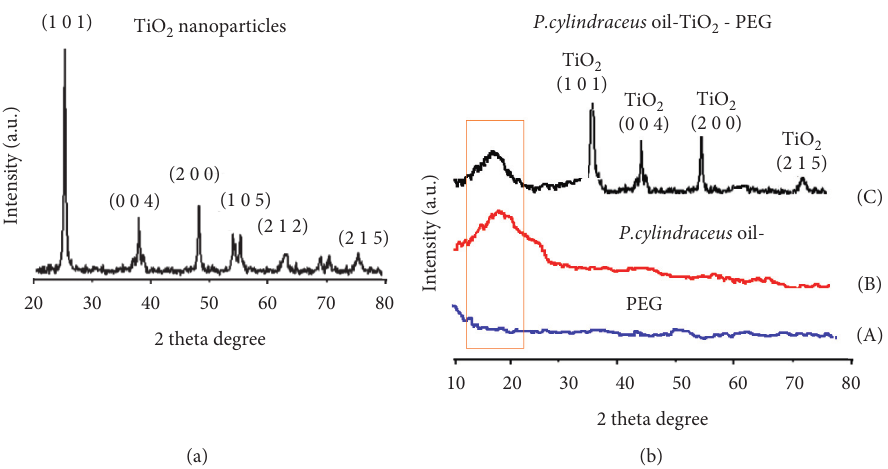
Figure 5: (a) XRD analysis of TiO 2 nanoparticles synthesized from the P. cylindraceus aqueous extract and (b) XRD patterns of (A) plain PEG, (B) P. cylindraceus oil-PEG, and (C) polymeric P. cylindraceus oil-TiO 2 -PEG bionanocomposite.